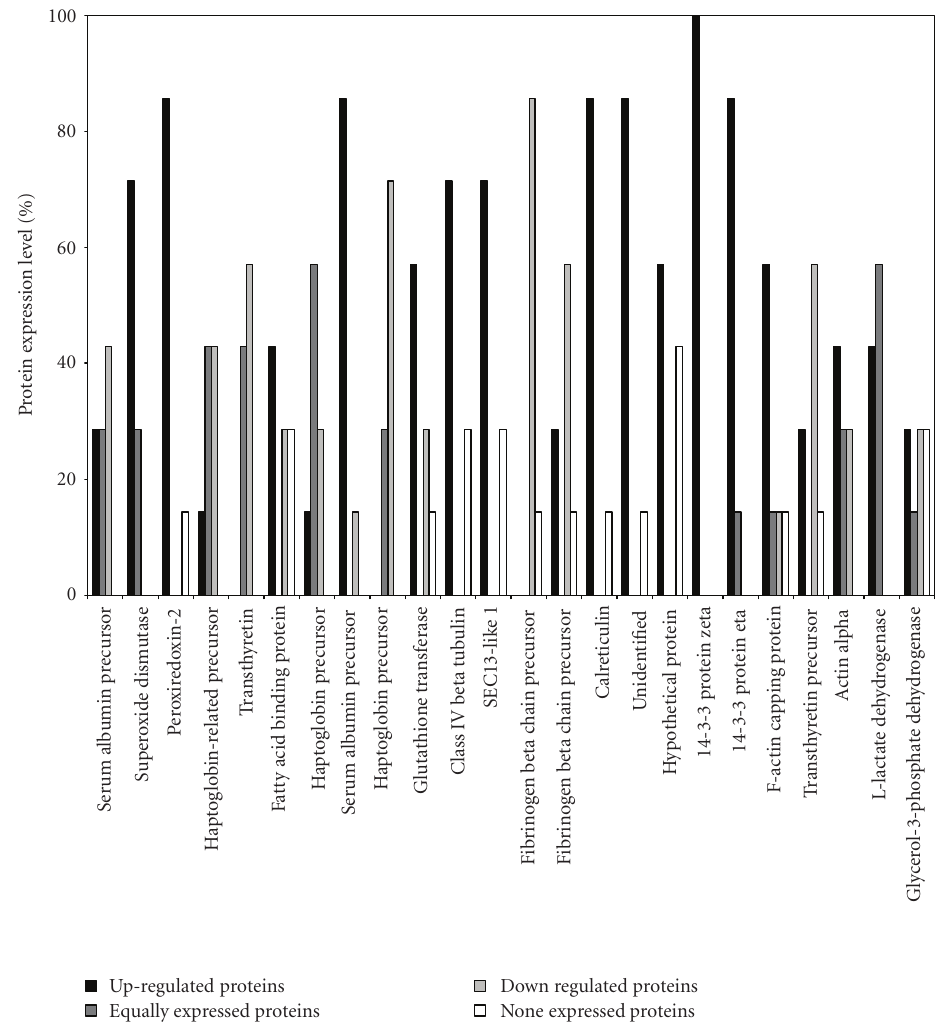
Figure 6: Distribution of proteins in Stage II